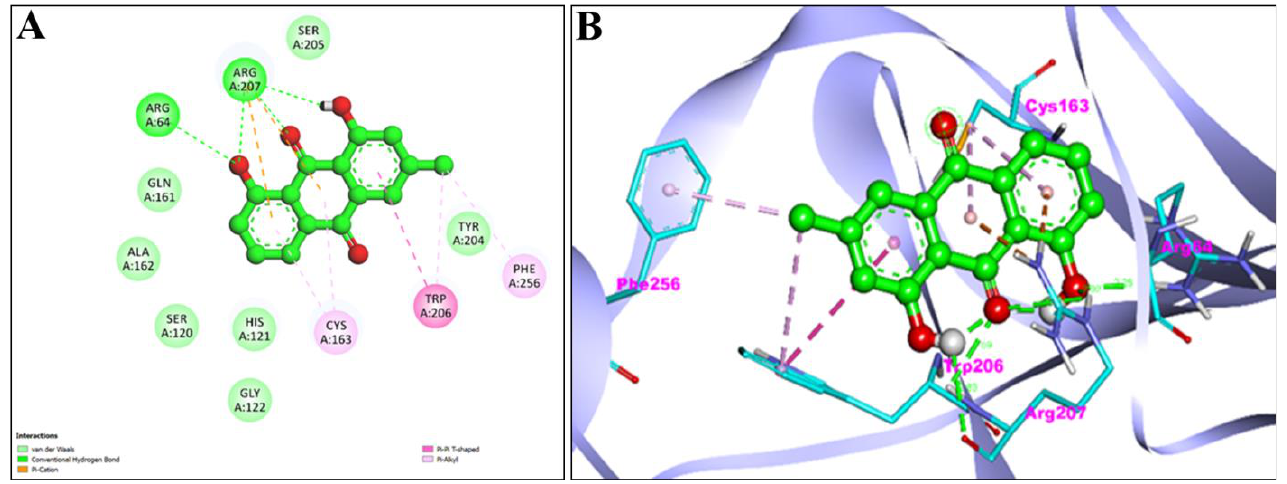
Figure 7. 2D ( A ) and 3D ( B ) representation of interaction of chrysophanol (green color) and caspase-3 protein (purple color with ribbon pattern) (PDB:4QU8).